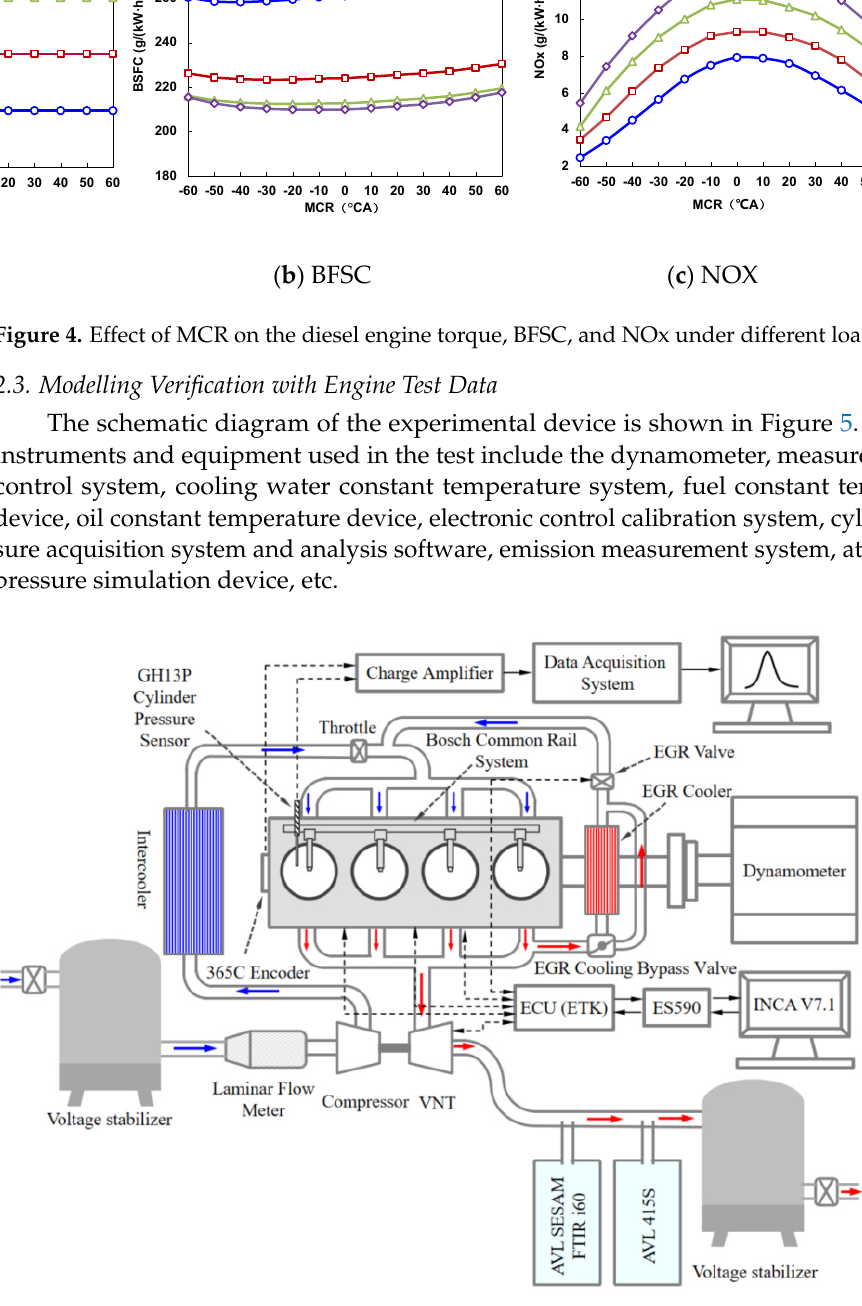
Figure 5. Schematic diagram of the experimental setup.